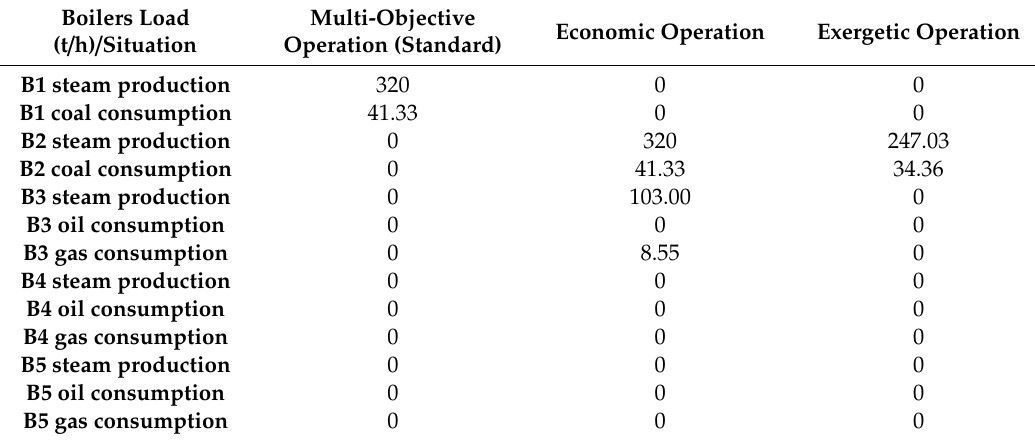
Table 10. Optimal scheduling results of purchased resources for SSS.